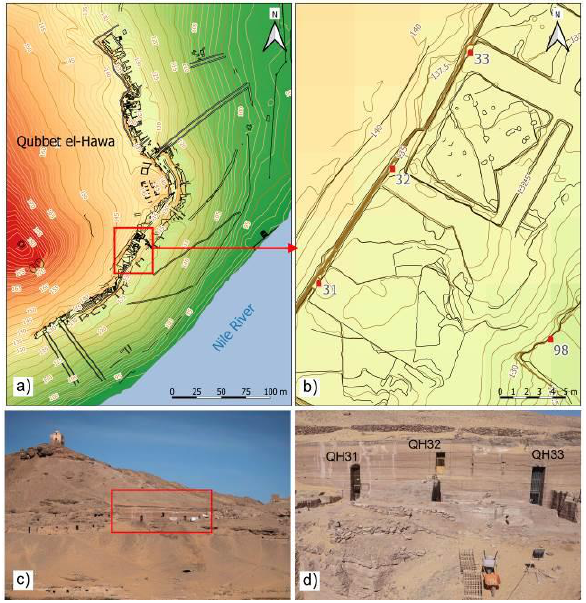
Figure 1. Study zone: a) map of the Necropolis of Qubbet el Hawa; b) location of the tombs; c) general view; d) detailed view of the entrance of the tombs.